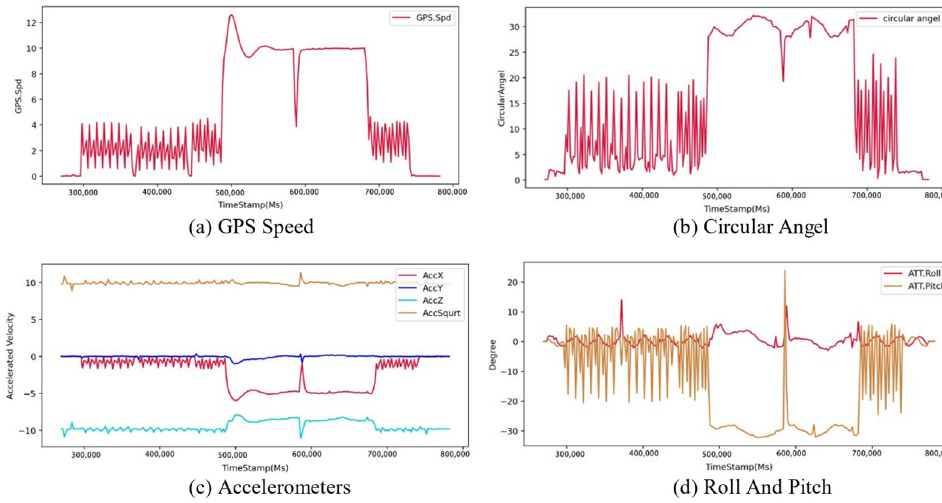
Figure 10. The status change of the drone when GPS fails.